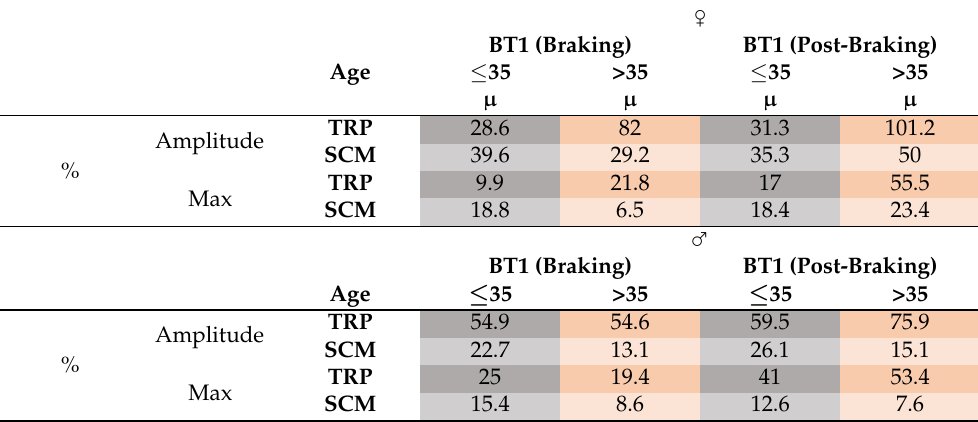
or ). P.P.O.M: ♀ ♂ Braking Post-Braking BT2 BT2